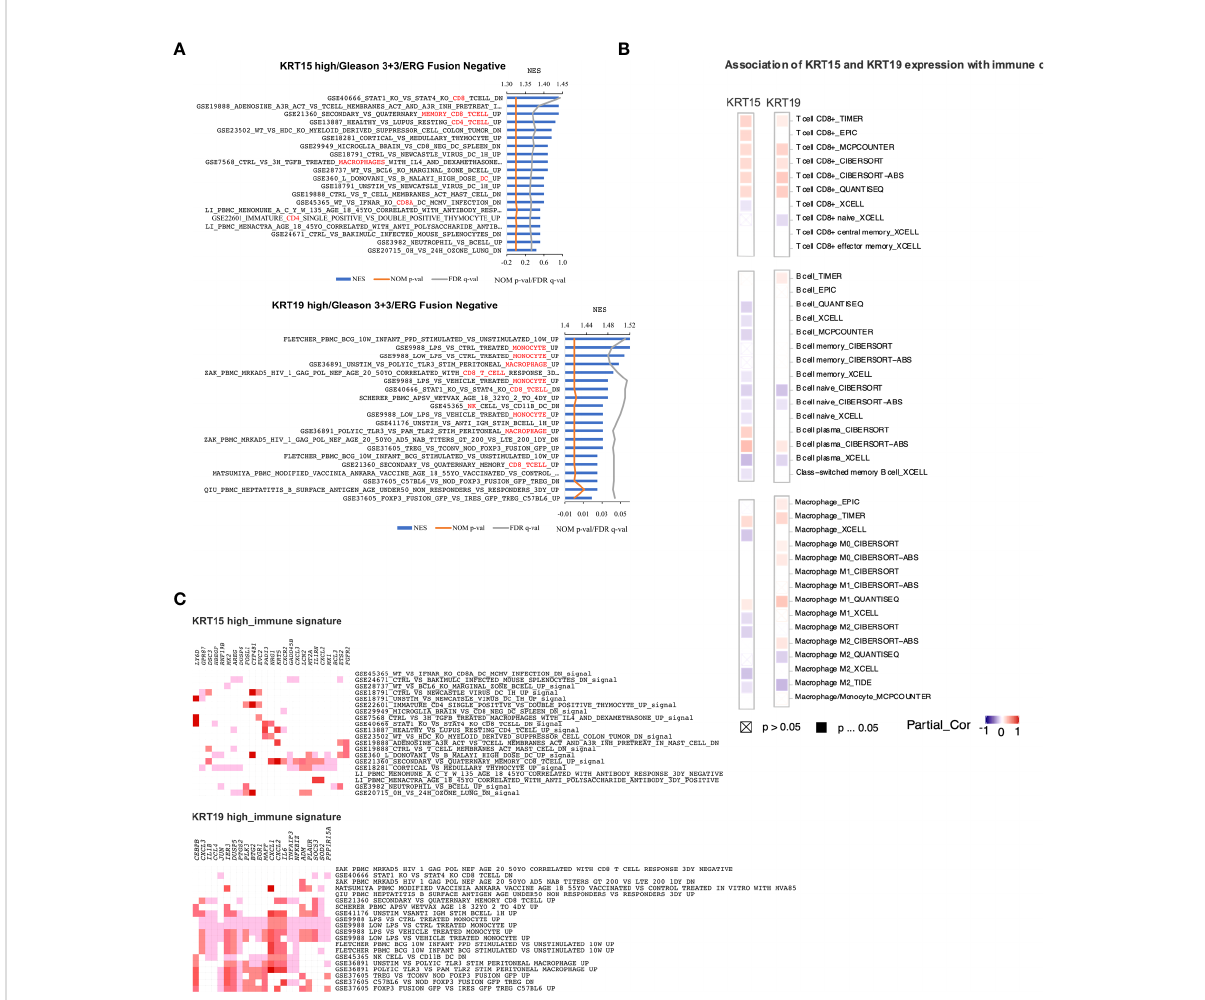
FIGURE 7 Immunogenic gene signatures associated with KRT15 and KRT19 expression in ERG fusion negative and Gleason 3 + 3 patients. (A) gene sets positively enriched in patients with high expression of KR15 (top) and KRT19 (bottom). (B) leading-edge genes associated with gene sets positively enriched in patients with high expression of KRT15 (top) and KRT19 (bottom). (C) immune cells in fi ltration associated with KRT15 and KRT19 expression. Squares with a cross indicate non-signi fi cant associations (p > 0.05), solid square indicates signi fi cant associations (p ≤ 0.05), and purple-red is association gradient (purple is for negative association and red for positive